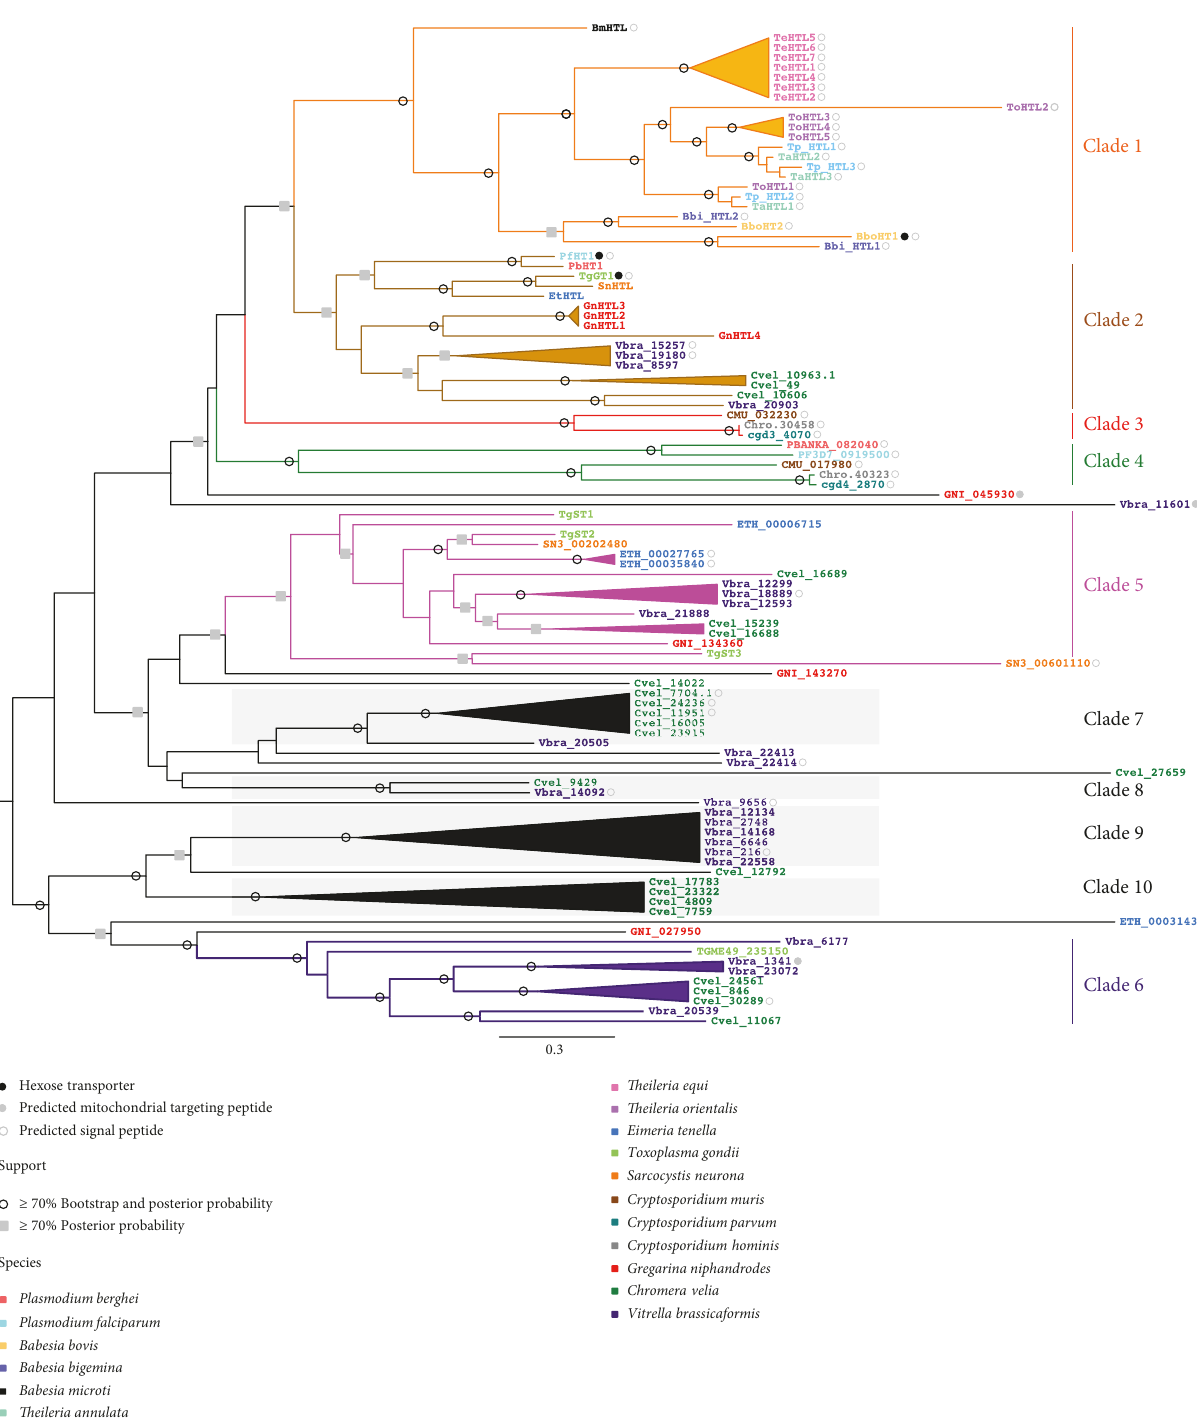
Figure 2: Apicomplexan sugar transporter phylogeny. Chromera velia and Vitrella brassicaformis sugar transporter gene families were used as outgroups. Phylogenetic clades are colored di ff erentially. Clades outlined with grey boxes are chromerid-speci fi c. Gene identi fi ers for each species are colored di ff erentially. See Supplementary Table 3 for gene identi fi ers and aliases. Closed black circle: hexose transporter. Closed grey circle: predicted mitochondrial targeting peptide. Open grey circle: predicted signal peptide. Open black circle: at least 70% bootstrap and posterior probability. Grey square: at least 70% posterior